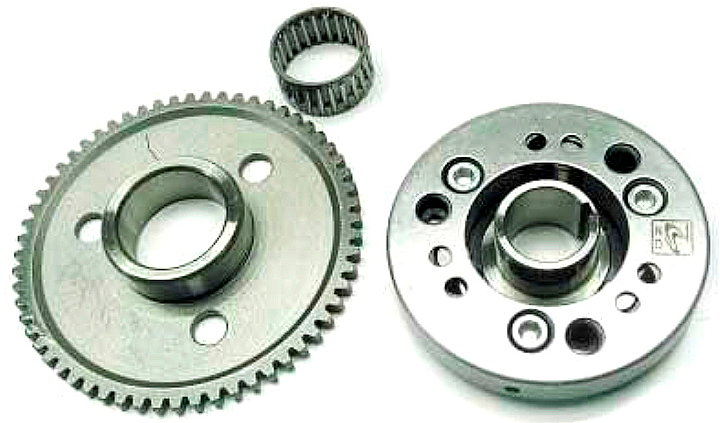
Figure 10. Clutch and one-way bearing.